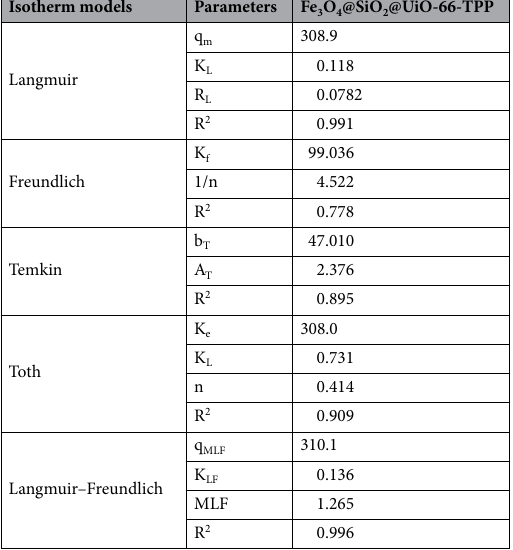
Table 2. Adsorption isotherm model constants derived from Langmuir and Freundlich